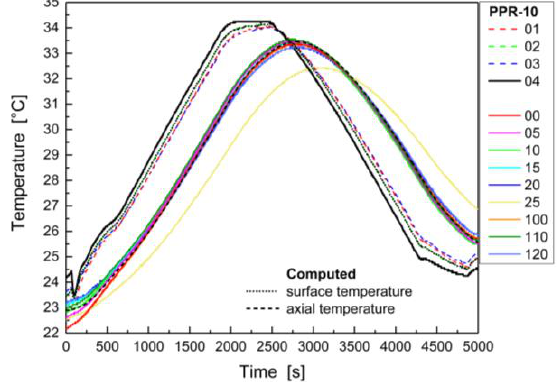
Figure 19. Time-history of measured temperatures and computed surface and axial temperatures (measurement B — temperature increase in climate chamber by 10 °C/probe 1).